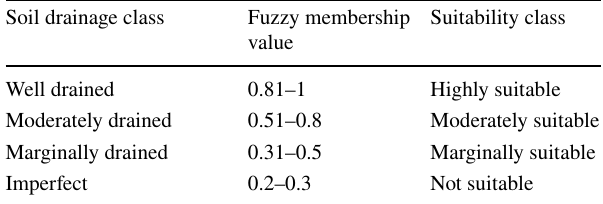
Table 5 Criteria for the classification of soil drainage